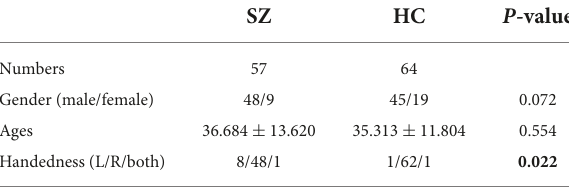
TABLE 1 Demographic information of the participants from COBRE